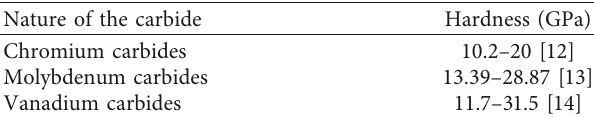
Table 5: Different carbides hardness. Nature of the